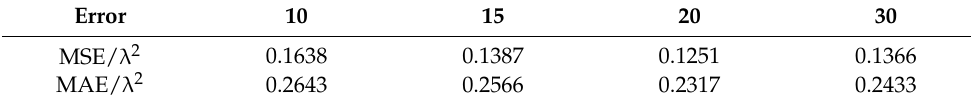
Table 6. Mean square error and mean absolute error of astmag on different time steps.